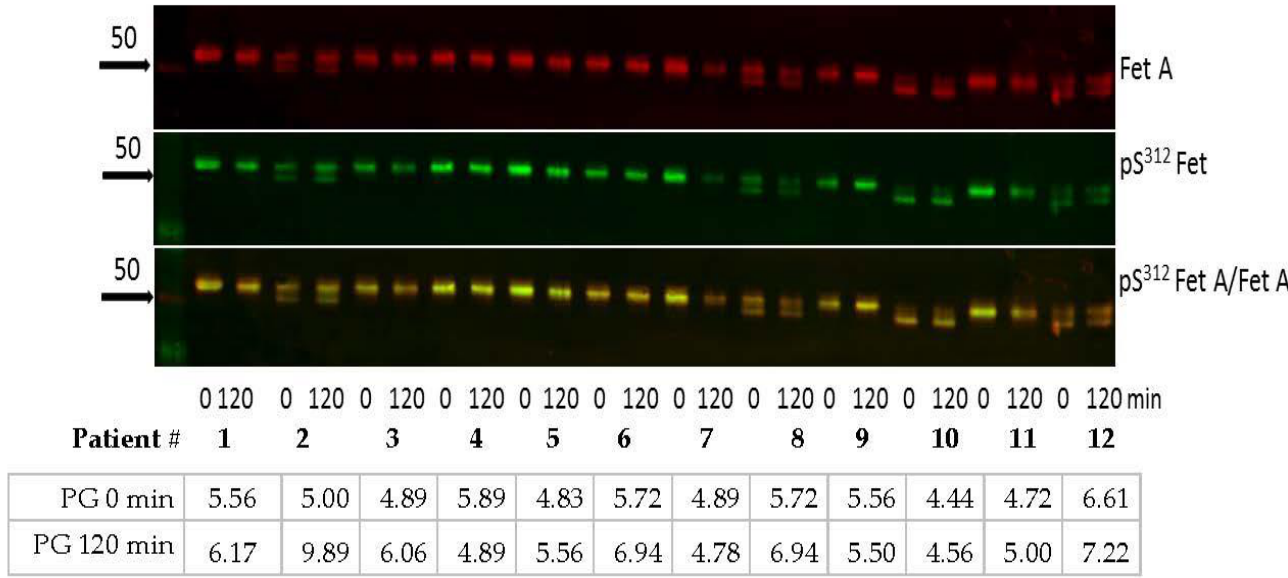
Figure 6. Effect of short-term metabolic changes on plasma pSer 312 pFet A and Fet A induced by an OGTT. Serum samples were obtained from 12 controls during an OGTT and sample taken at 0 min (basal) and 120 min were analyzed by Western blotting as described in the Method section. PG: Plasma glucose in mmol/L. Bold arrows indicate molecular weight markers .